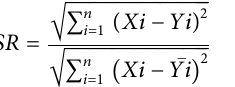
Frontiers in Earth Science |